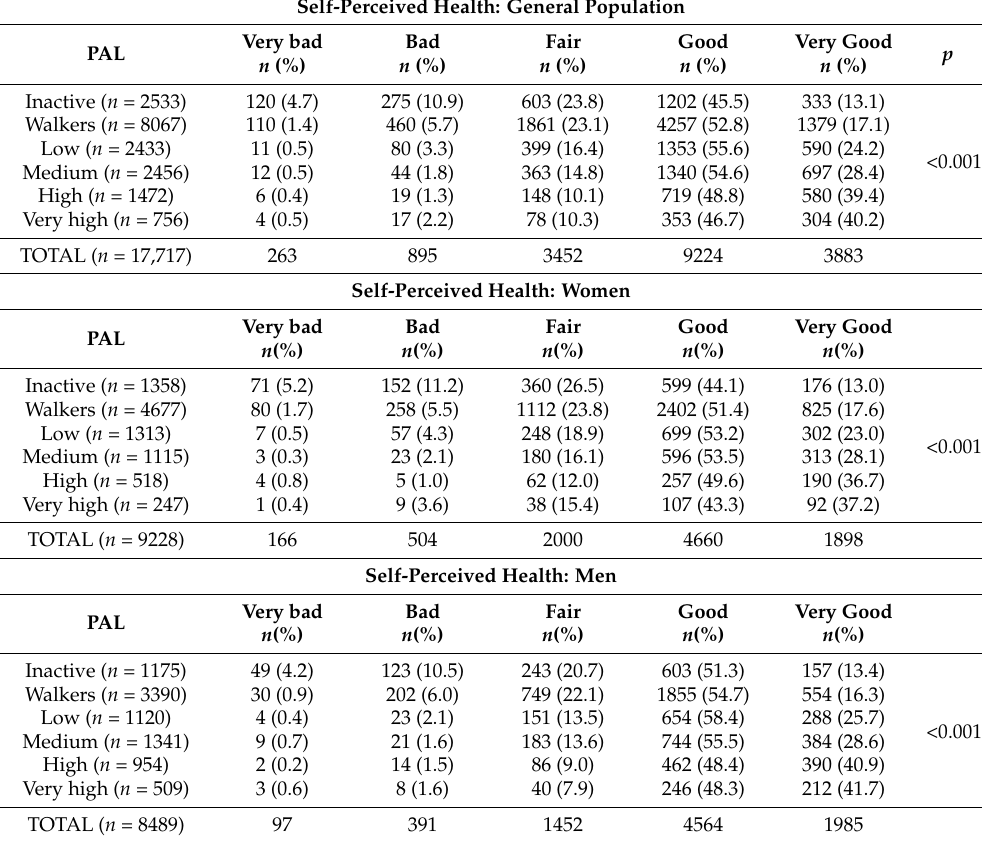
Table 3. Associations between the level of physical activity and self-perceived health in the Spanish population through the ENSE